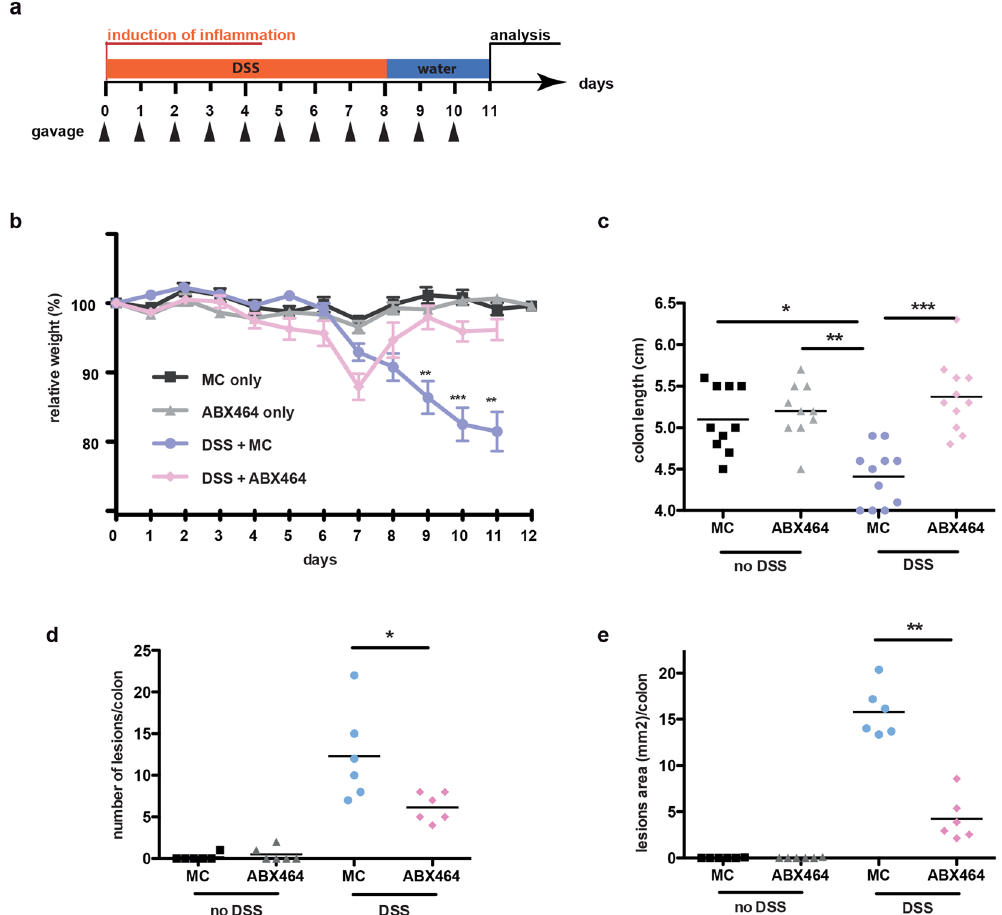
Figure 1. ABX464 treatment suppresses disease severity in DSS-induced colitis. ( a) C57BL/6 mice (n =